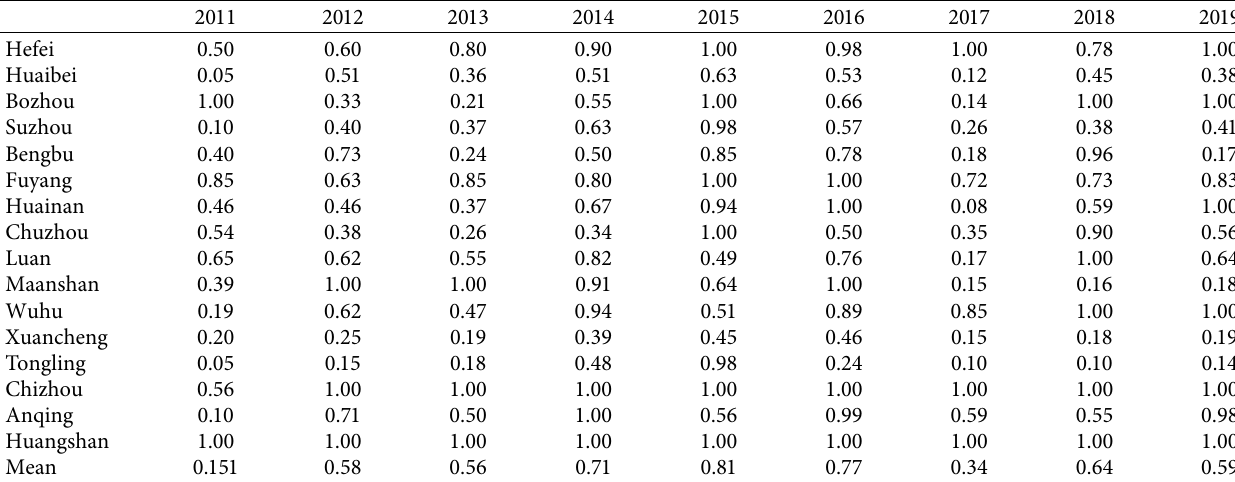
Table 2: Results of overall efficiency on inbound